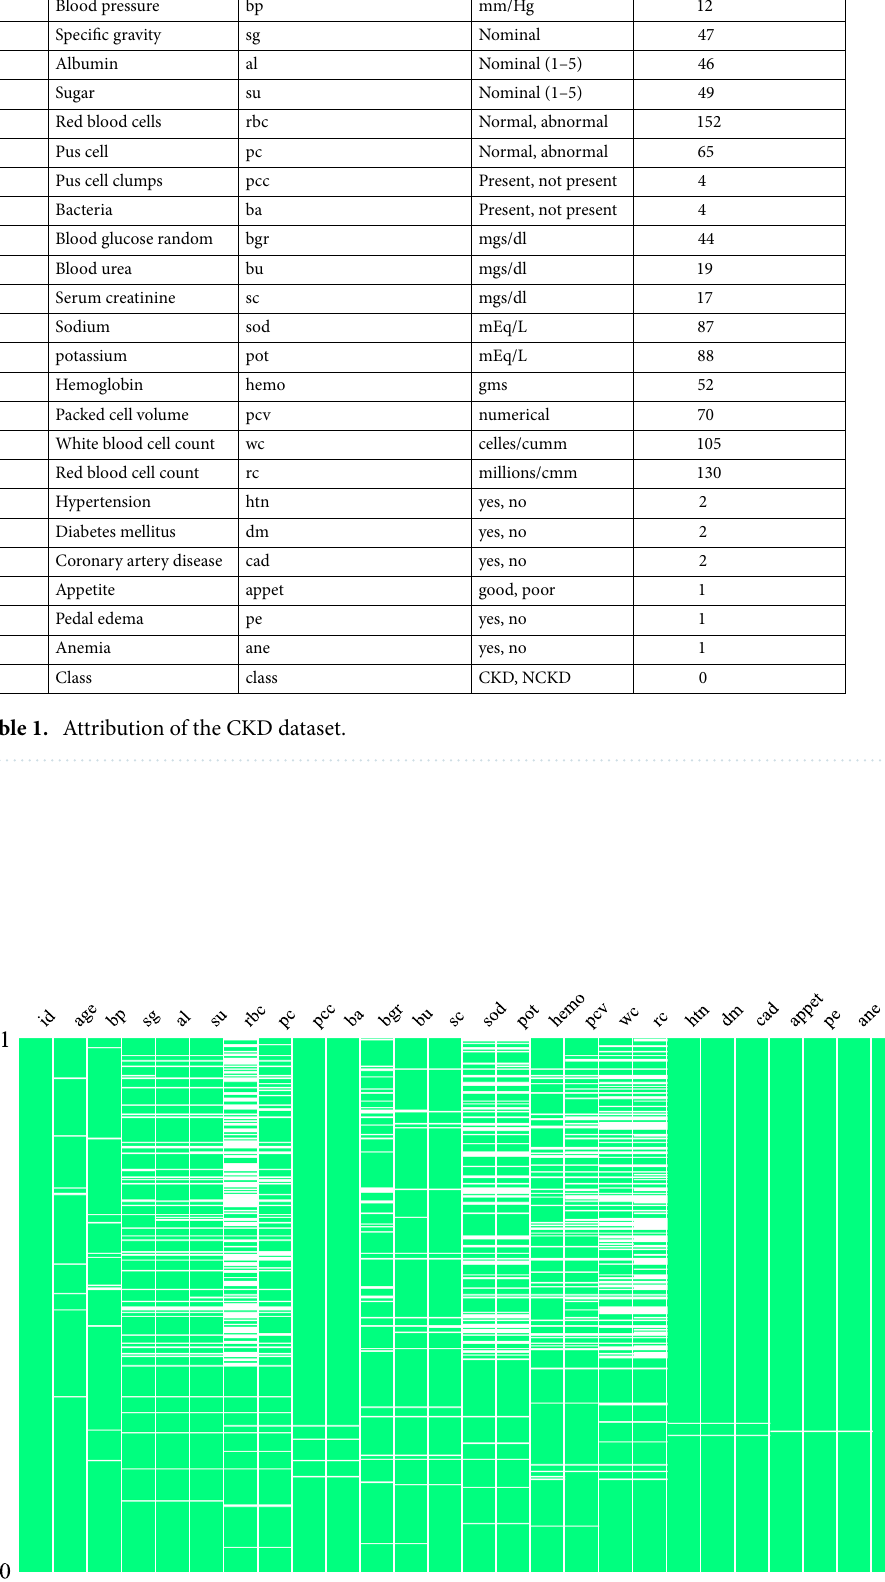
Figure 2. Visualization of missing